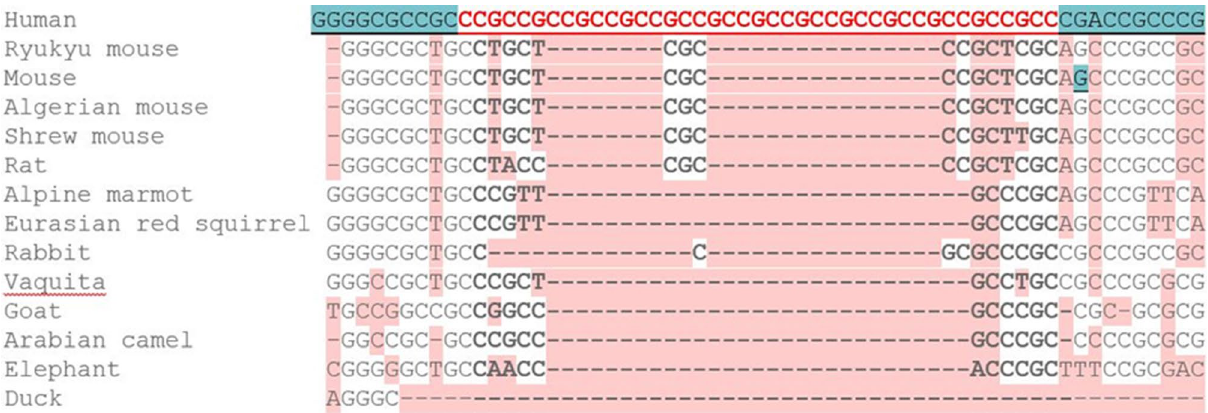
Figure 6. Sequence alignment of the RASGEF1C (GGC)-repeat across non-primates, using the Ensembl alignment program. Human is depicted as the reference sequence. Reverse strand depicted. (GGC)-repeat of > 2-repeats was not detected in